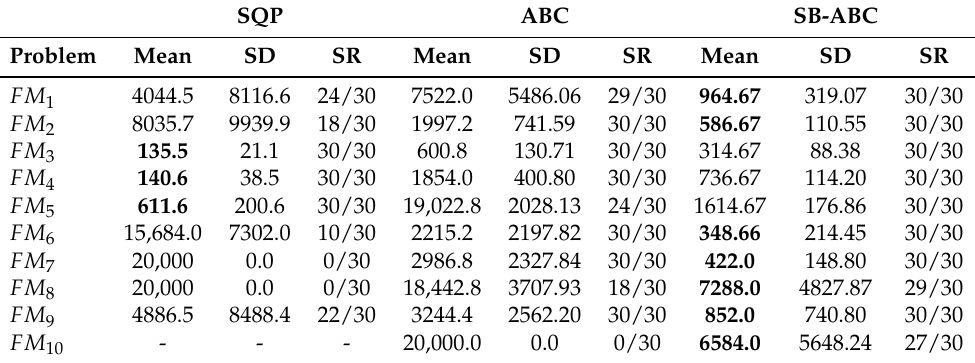
Table 5. Comparison results of the ABC and SB-ABC for the FM 1 – FM 10 minimax problems. SQP ABC